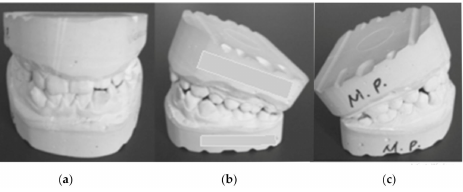
were cast. Figure 3 shows images of these models.